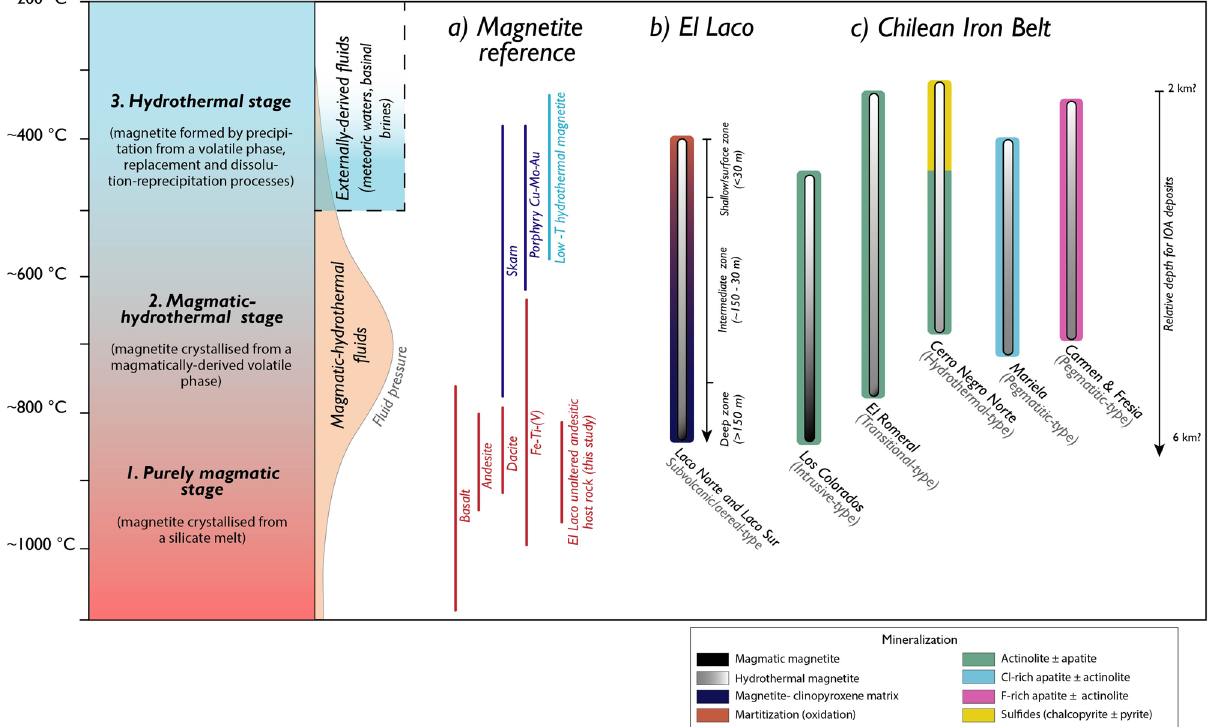
Figure 4. Thermal evolution of Andean IOA deposits unraveled by magnetite thermometry data. Stages 1 and 2 are characterised by purely magmatic (~ 1000 to 800 °C) and magmatic-hydrothermal (~ 800 to 600 °C) temperature conditions, respectively. S tage 3 comprises purely hydrothermal (< 600 °C) conditions. (a) Reference temperatures of magnetite for igneous rocks (basalt, andesite, dacite), and magmatic/magmatic-hydrothermal (Fe–Ti, V, skarn, porphyry Cu–Mo–Au) ore deposits, and low-temperature (T) hydrothermal magnetite (replacement and disseminated); (b,c) thermal evolution of El Laco (b) and IOA deposits from the Chilean Iron Belt (c) . See text for